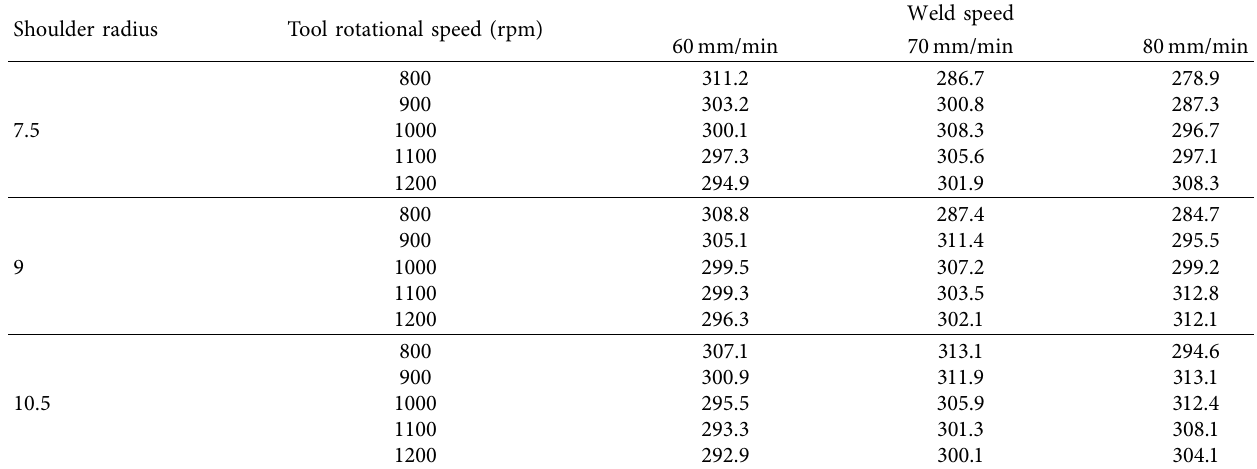
Table 4: Experimental results on mechanical property (yield strength in